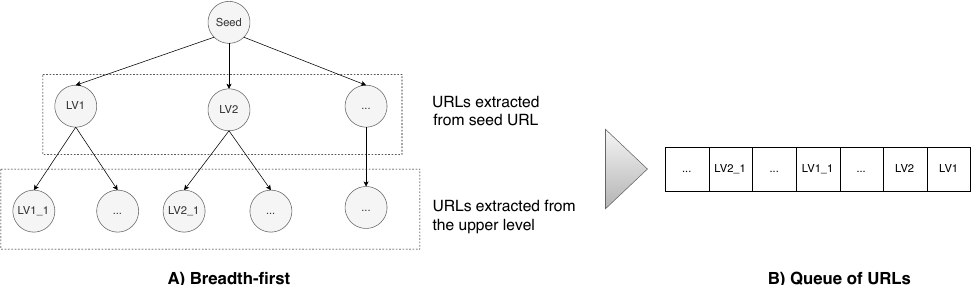
Figure 7. Breadth-first URL extraction process ( A ) and queue URLs ( B ) after adding the extracted URLs. LV denotes the level of each